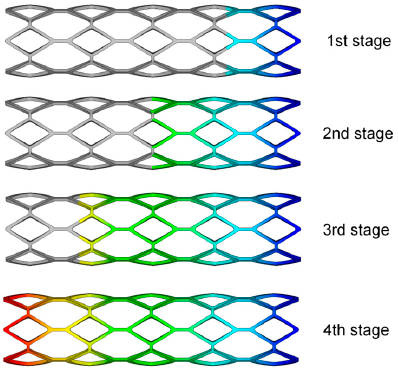
Figure 6. The injection molding process of a stent based on the ART18Z platform.